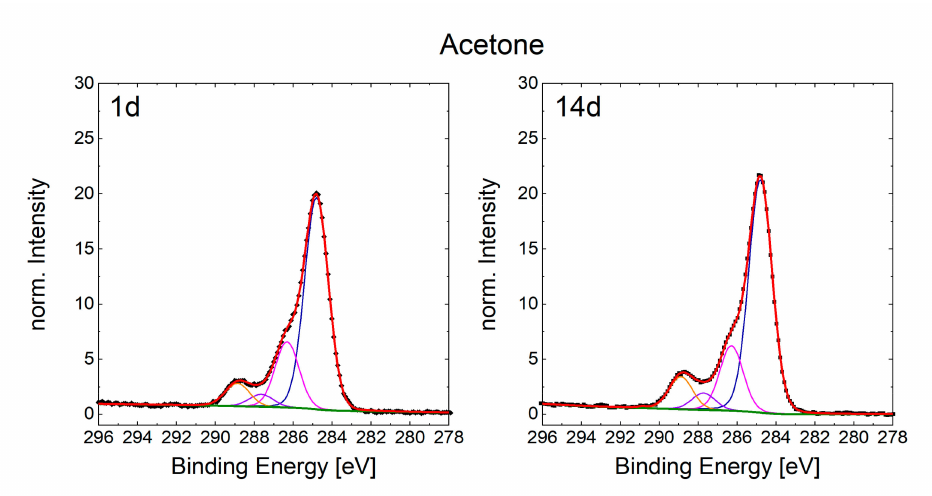
Figure A3. C 1s spectra of structured sample 1 and 14 days after cleaning with